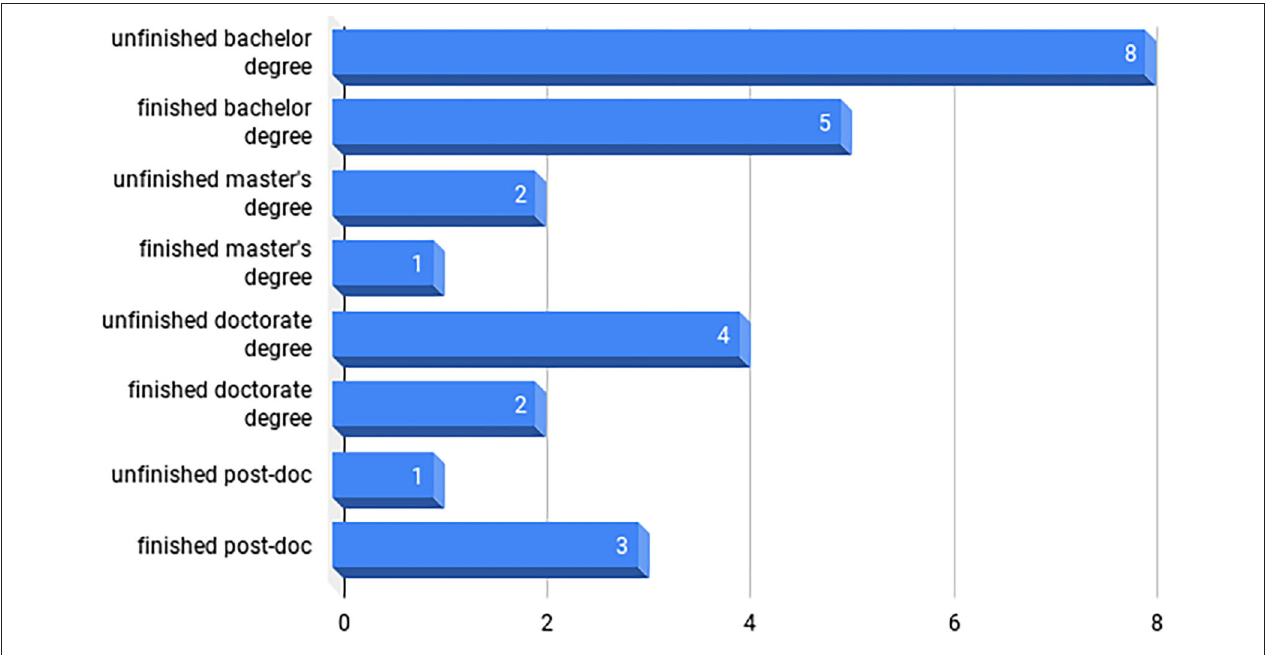
FIGURE 3 | Education attainments of science Youtubers.